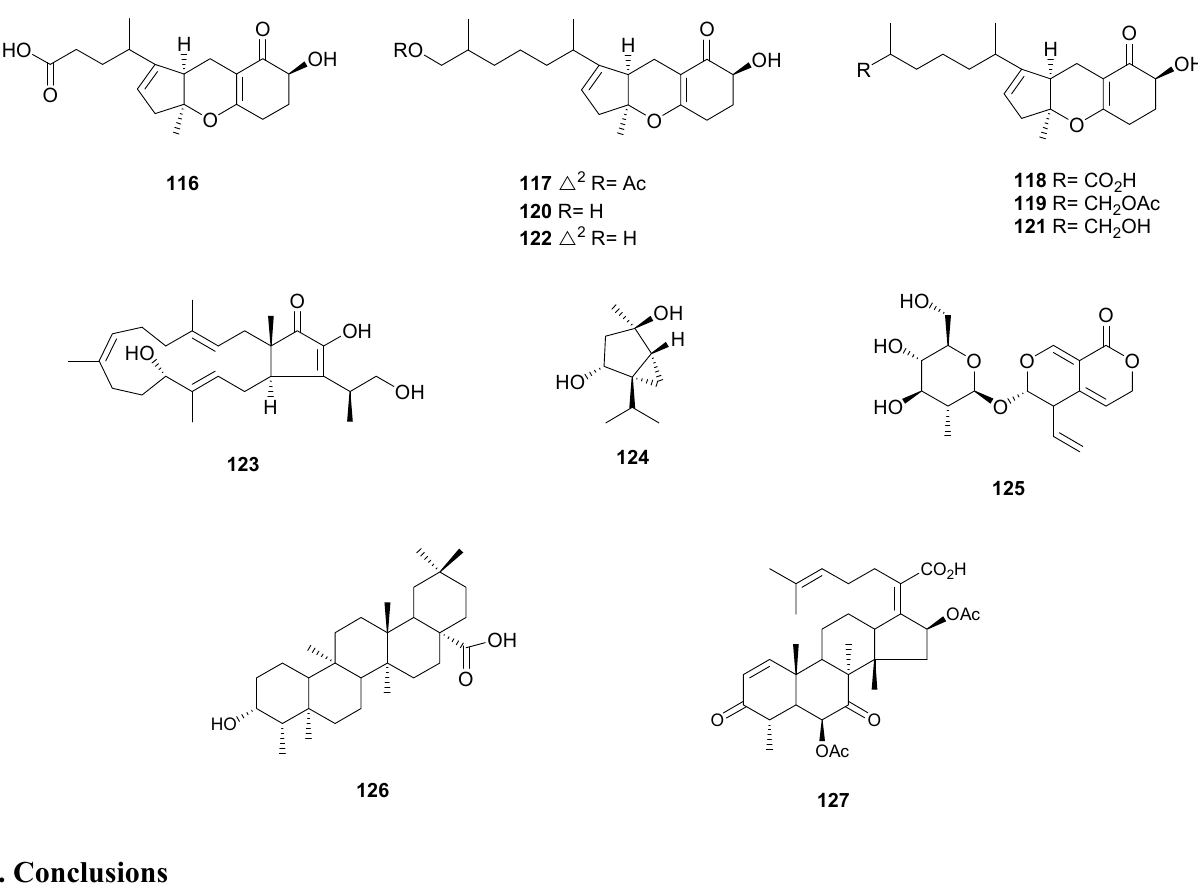
Figure 4. Chemical structures of meroterpenes from endophytic fungi.